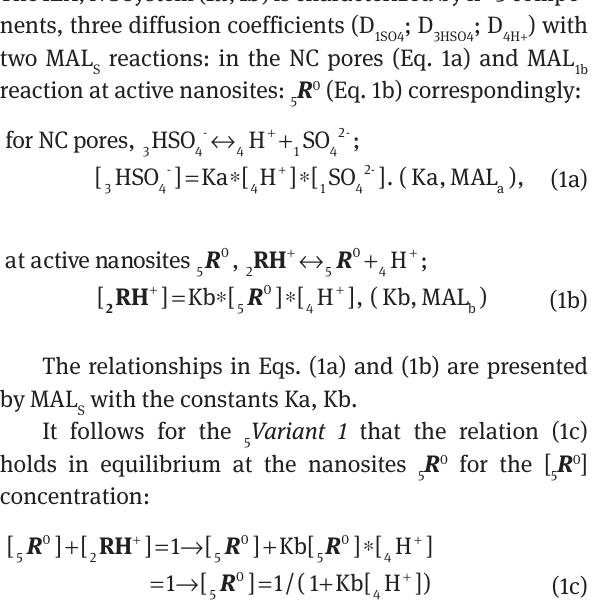
; D ; D ) with 1Cl 4H+ 5HCl reactions (2.2), S